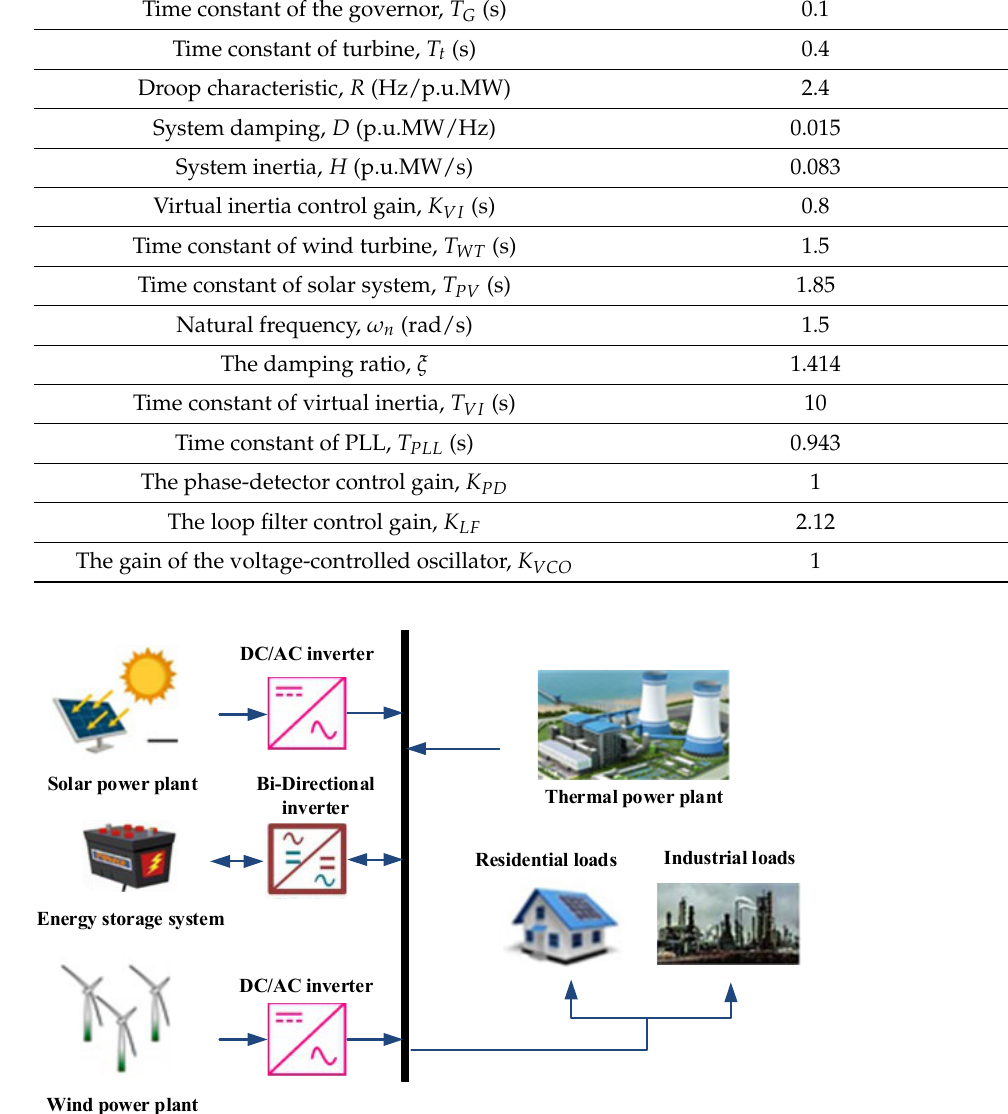
Figure 1. A schematic diagram of the islanded microgrid.